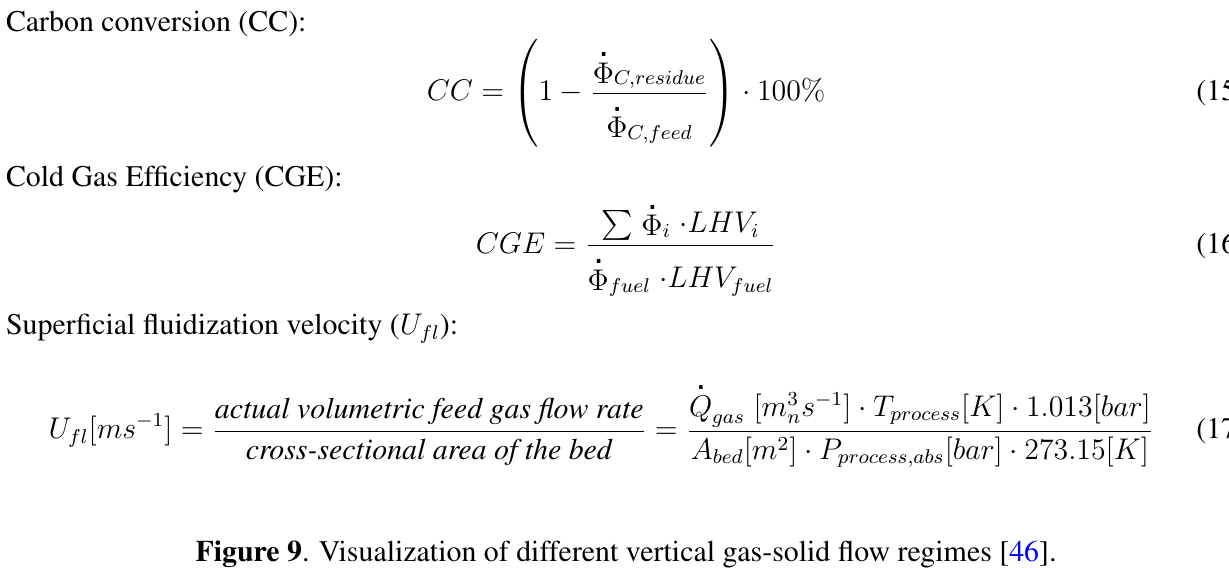
Figure 9 . Visualization of different vertical gas-solid flow regimes